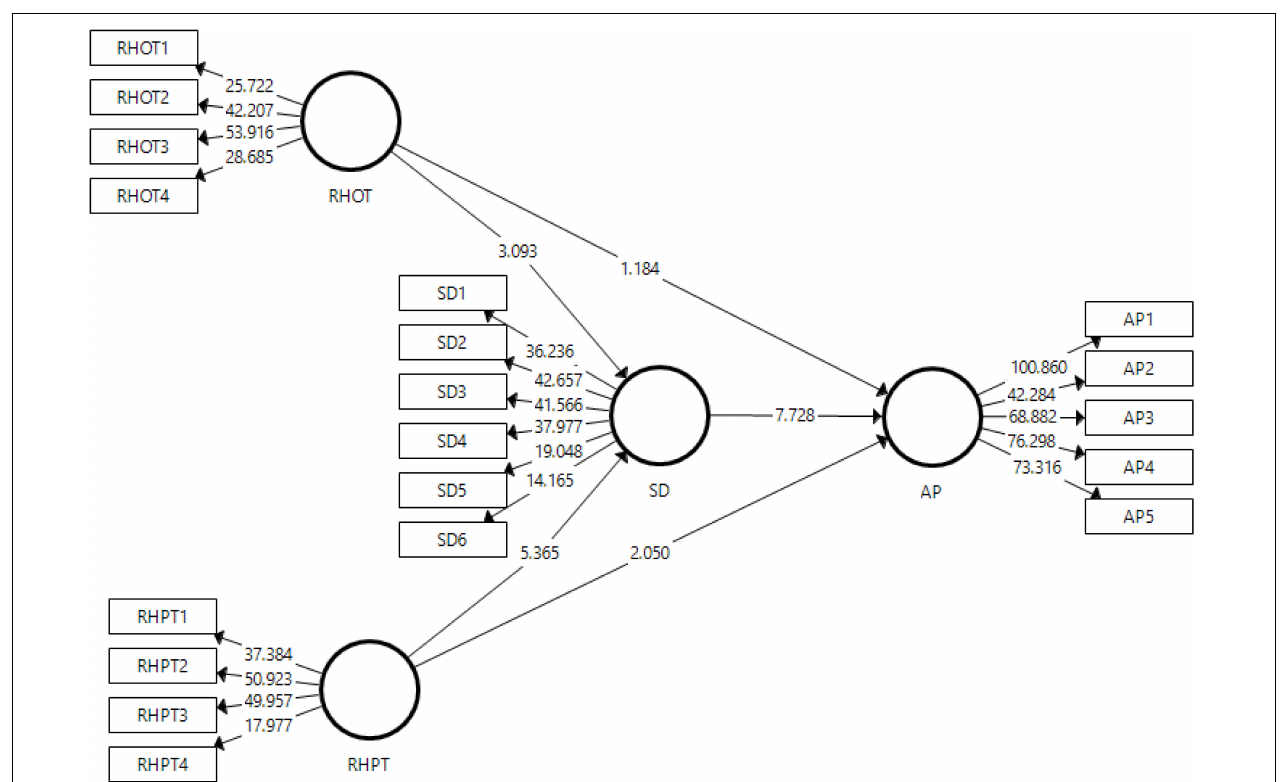
FIGURE 3 | The output of the structural model. RHOT, rationalized knowledge hiding—online education; RHPT, rationalized knowledge hiding—physical education; SD, students’ disengagement; AP, students’ performance. TABLE 5 | Direct